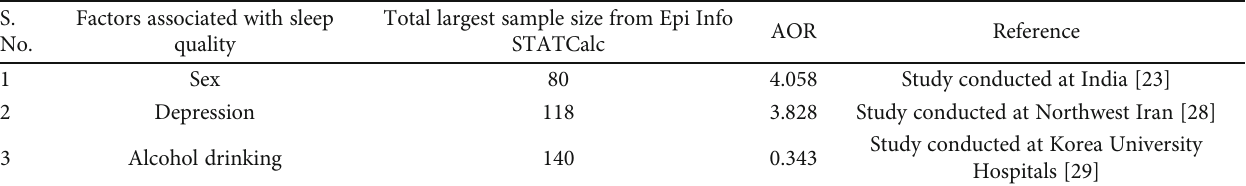
Table 1: Sample size for signi fi cant factors that a ff ect sleep quality at Debre Markos Referral Hospital Chronic Illness Follow-Up Clinic, 2018.